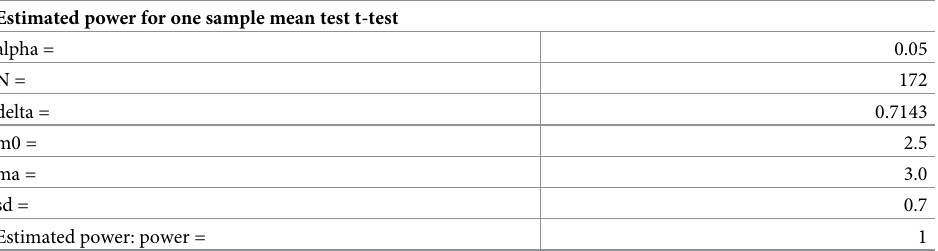
Table 1. Estimated power for a one-sample mean test t-test. Estimated power for one sample mean test